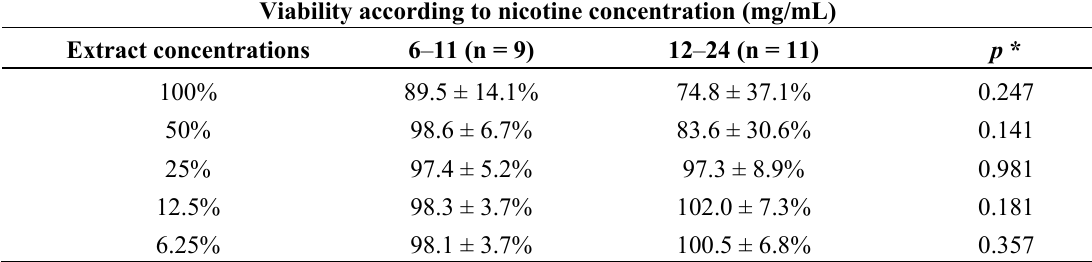
Table 4. Myocardial cell viability according to nicotine concentration of the electronic cigarette samples tested at 3.7 volts (6.2 watts).